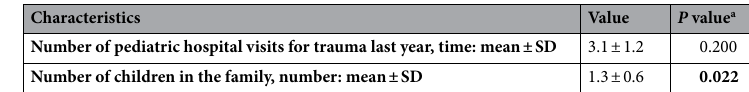
Table 1. Characteristics of the study population and univariate analysis results (n = 180). Significant values are in [bold]. The abbreviation for China Yuan is RMB. a The result of univariate analysis in which the dependent variable was total average score (SCL-90).